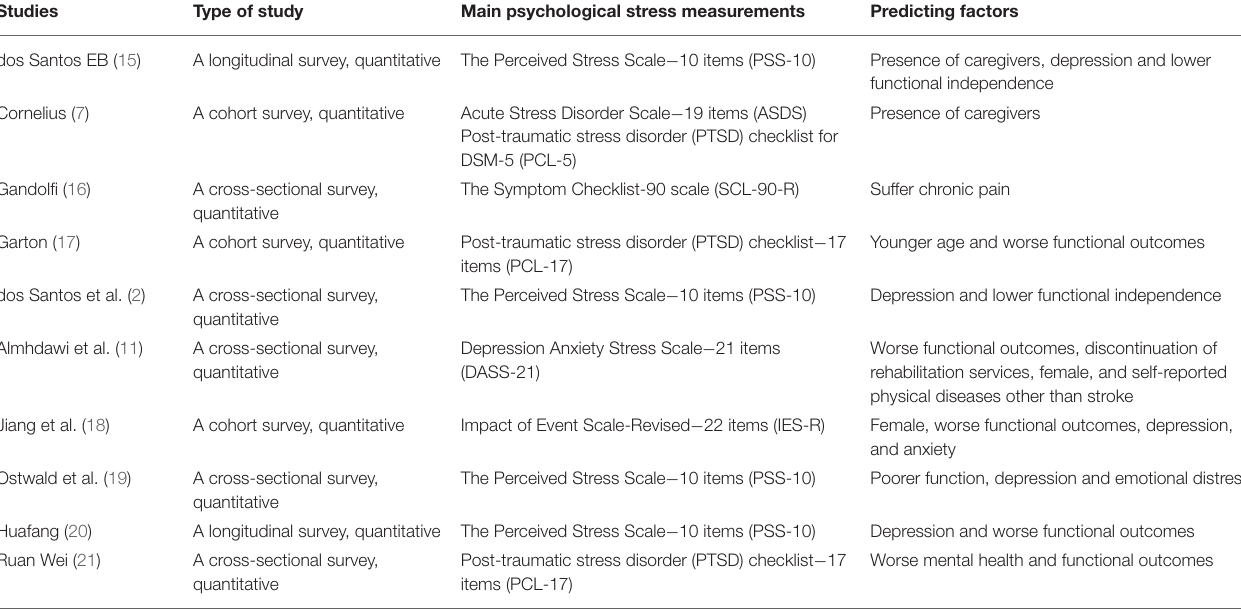
TABLE 1 | Different types and measurement methods of psychological stress after stroke and its premorbid predicting factors.